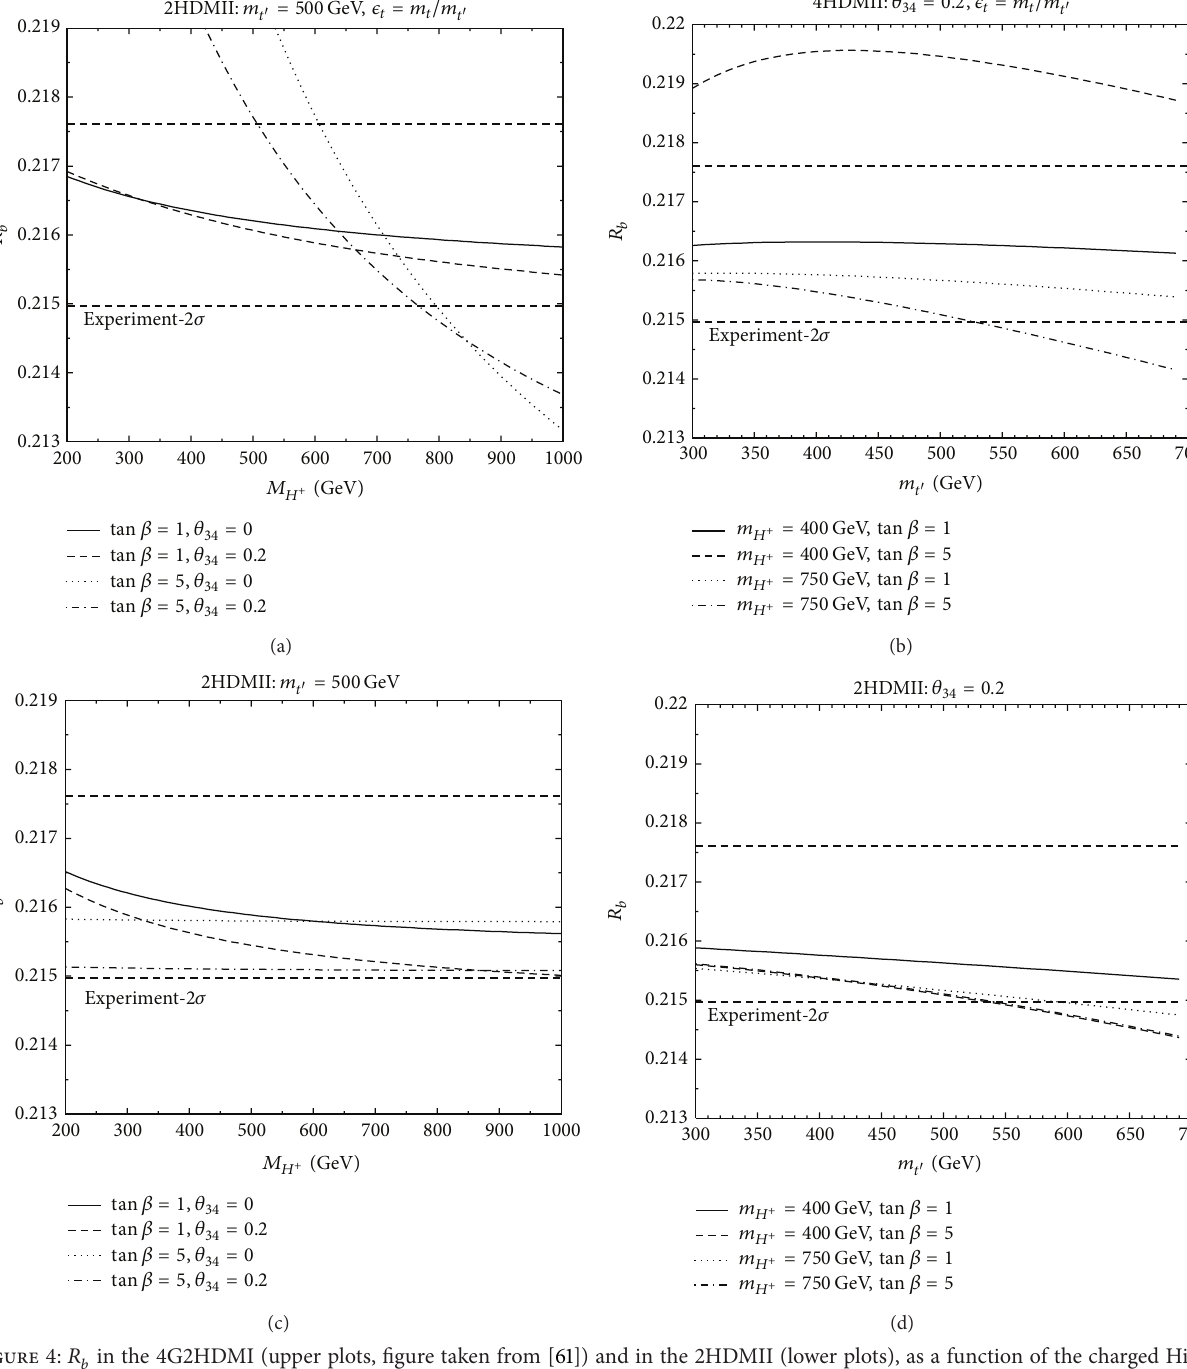
= 𝑚 /𝑚 𝑡 𝑡 𝑡 󸀠 . The long-dashed horizontal lines